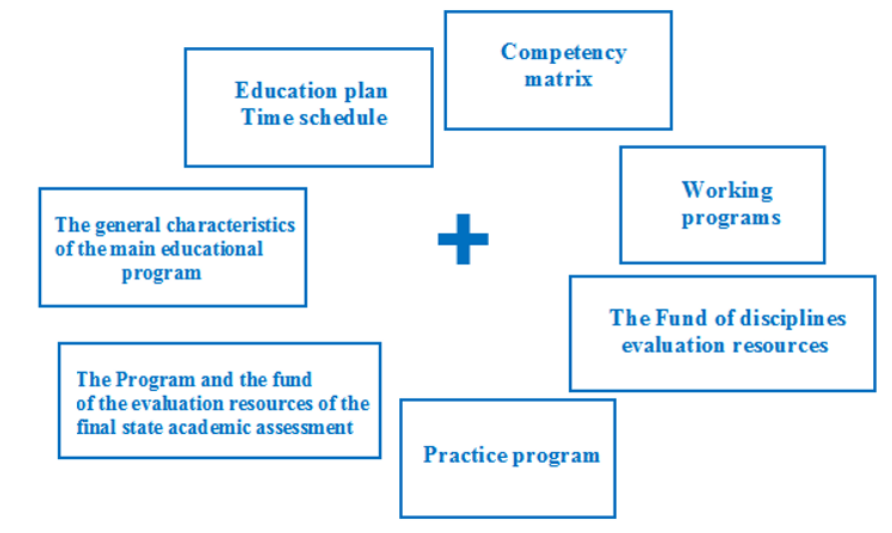
Fig. 2. The MEP main